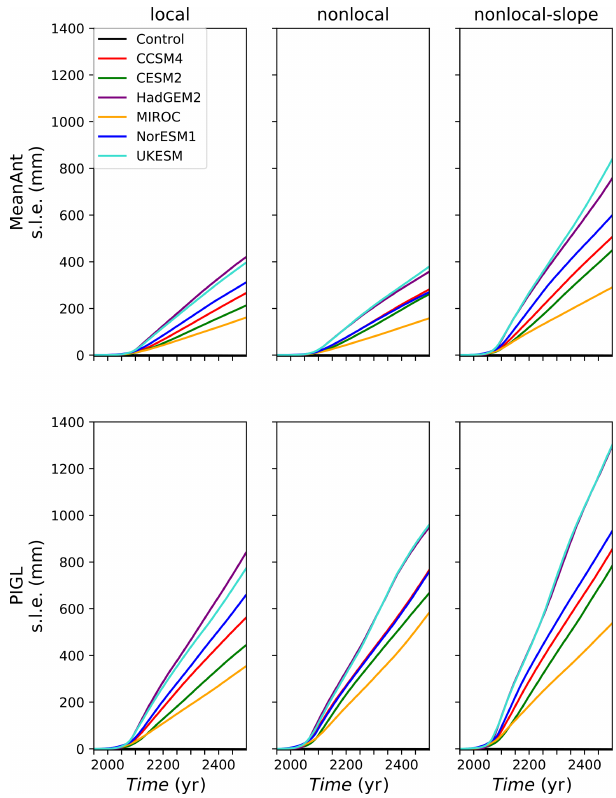
Figure 11. Sea-level rise (mms.l.e.) from Antarctic ice loss in 550- year ocean-forced projection experiments. The three columns cor- respond to the three melt parameterizations and the two rows to the two calibrations. Each panel shows the SLR response to ocean forc- ing from six AOGCMs, along with an unforced control